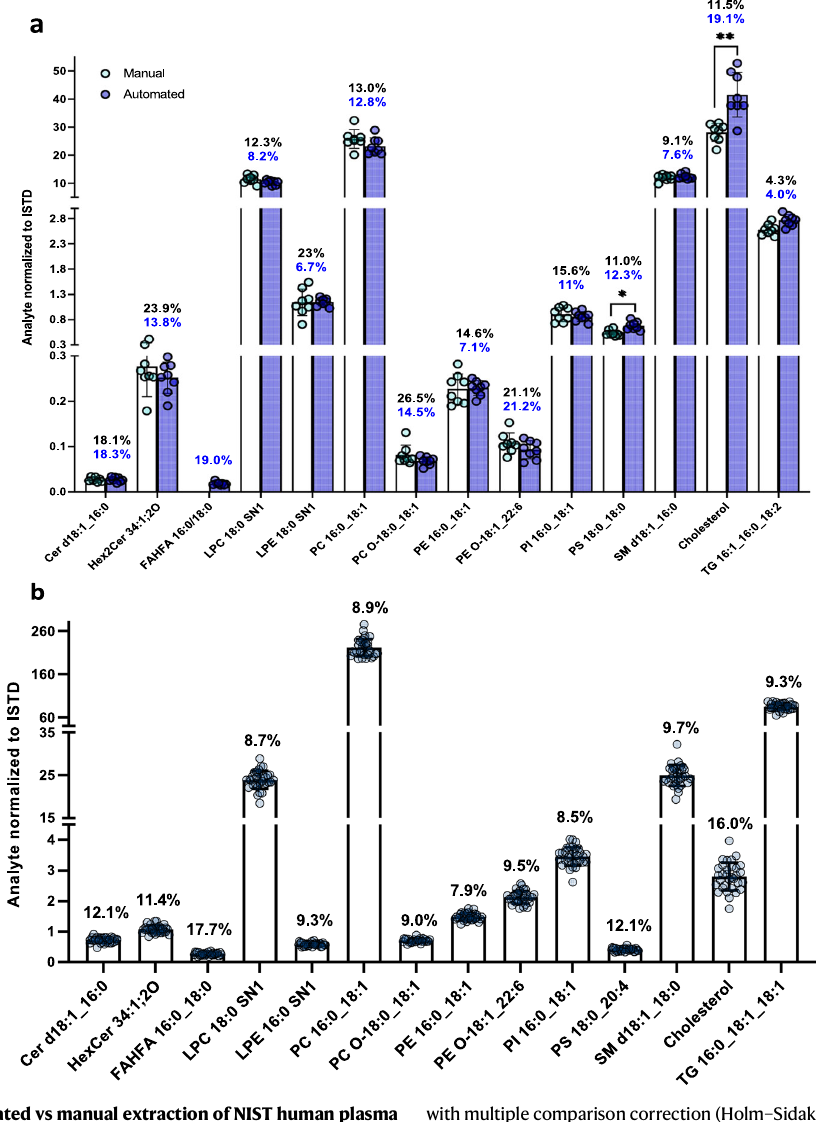
withmultiplecomparisoncorrection (Holm – Sidakmethod)wasused (t PS 36:0 (14)= 4.111, p =0.012630; t Cholesterol (14) = 4.424, p =0.007482). Bars represent mean values ± standard deviation (SD). * p <0.05; ** p <0.01. b Depicted are values from representative lipid species extracted from NIST plasma SRM, normalized to their corresponding ISTDs. Measurement was conducted in negative ion mode. The displayed numbers show the CV. Each dot represents an independent extraction ( n =32). Bars represent mean values±(SD). Source data are provided as a Source data fi le and in Supplementary Data